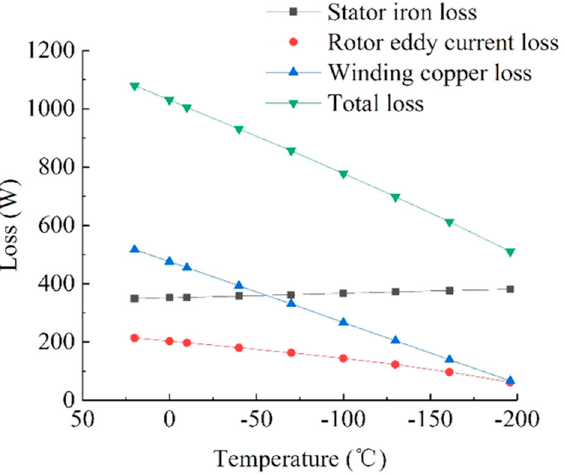
Figure 15. Comparison diagram of motor loss at various temperatures.